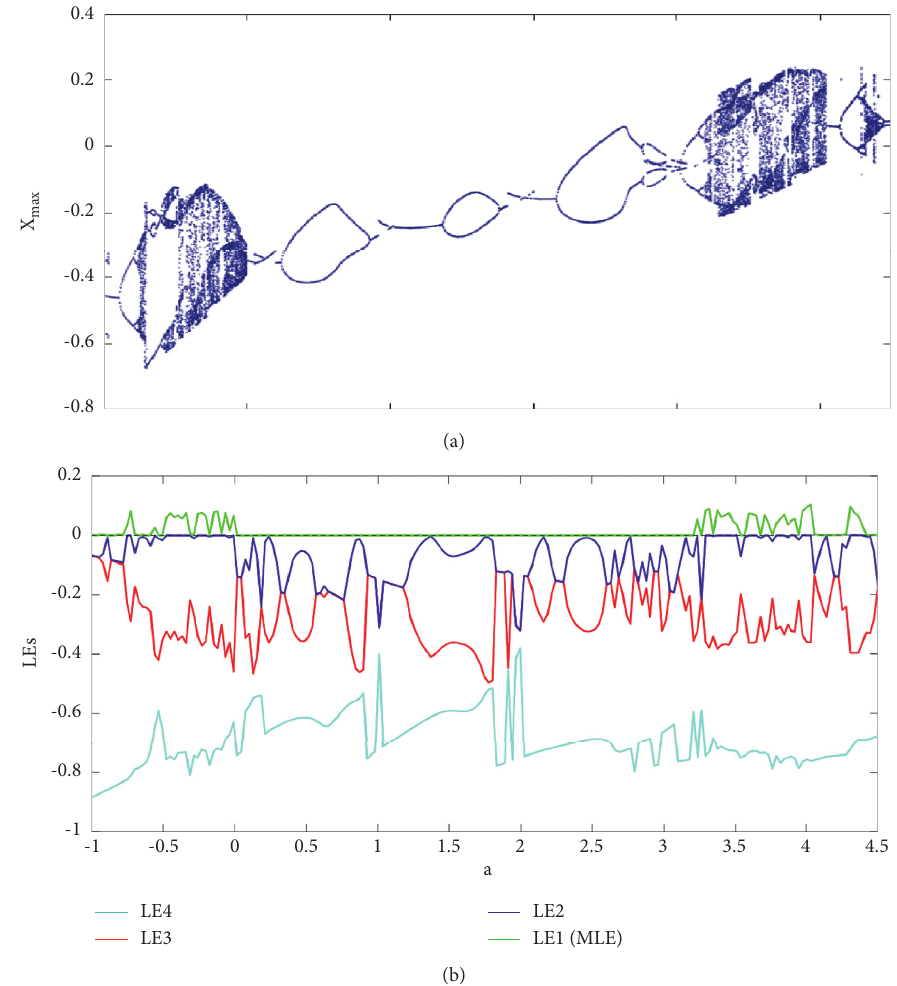
Figure 3: (a) Bifurcation diagram and (b) Lyapunov exponents of system (2) when parameter a changes and b � 1. The initial conditions are (− 2 . 77 , 0 . 53 , 2 . 7 , − 0 . 34 )